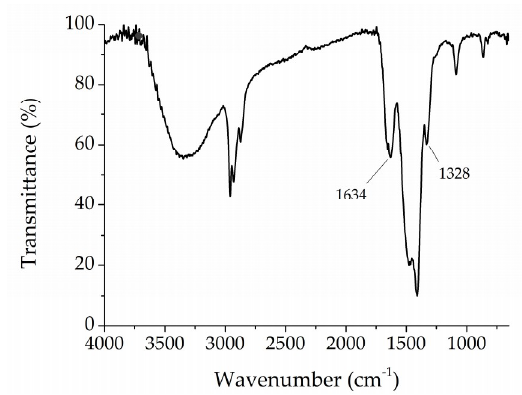
Figure 4. μFT-IR spectrum acquired after seven minutes from the beginning of the analysis showing the reaction pathway of carbonation process for NBU.